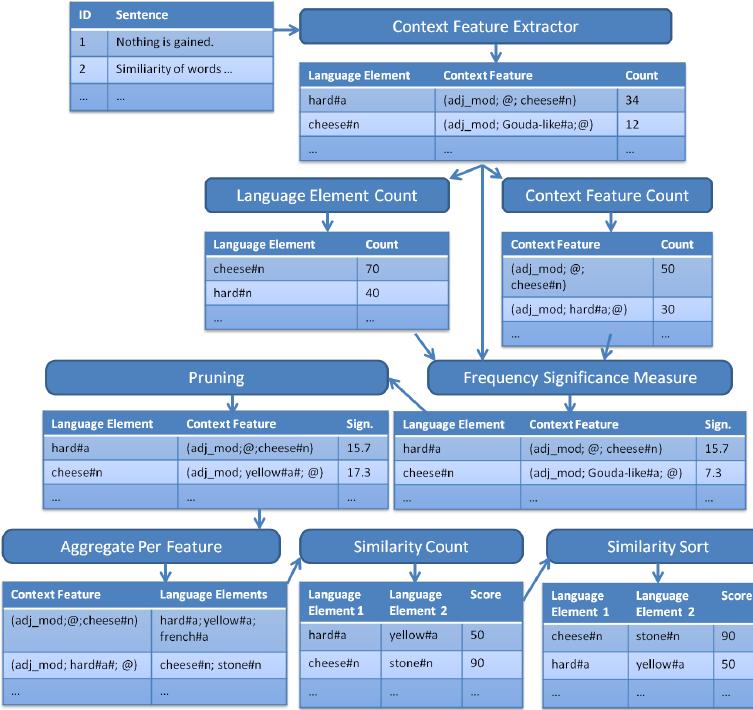
Figure 2: Workflow of the data